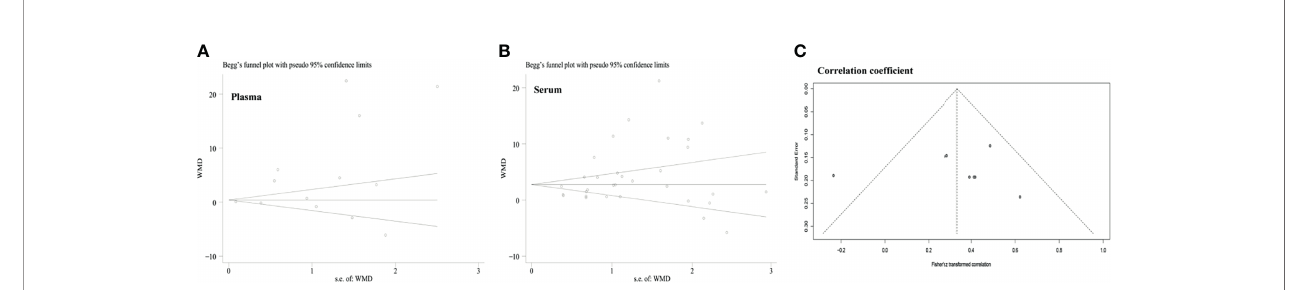
FIGURE 6 | Funnel plots were employed to assess the publication bias among the included studies examining the relationship of leptin levels with OSAS. (A) Funnel plot of the plasma leptin levels in patients with OSAS versus the control group. (B) Funnel plot of the serum leptin levels in patients with OSAS versus the control group. (C) Funnel plot of the association between the correlation coef fi cient and AHI. AHI, apnea-hypopnea index; OSAS, obstructive sleep